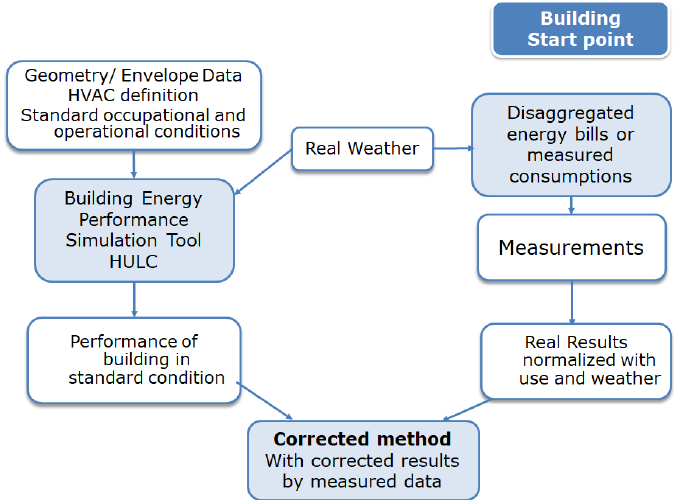
Figure 3. Diagram of the proposed procedure to correct the estimation using the energy bills.